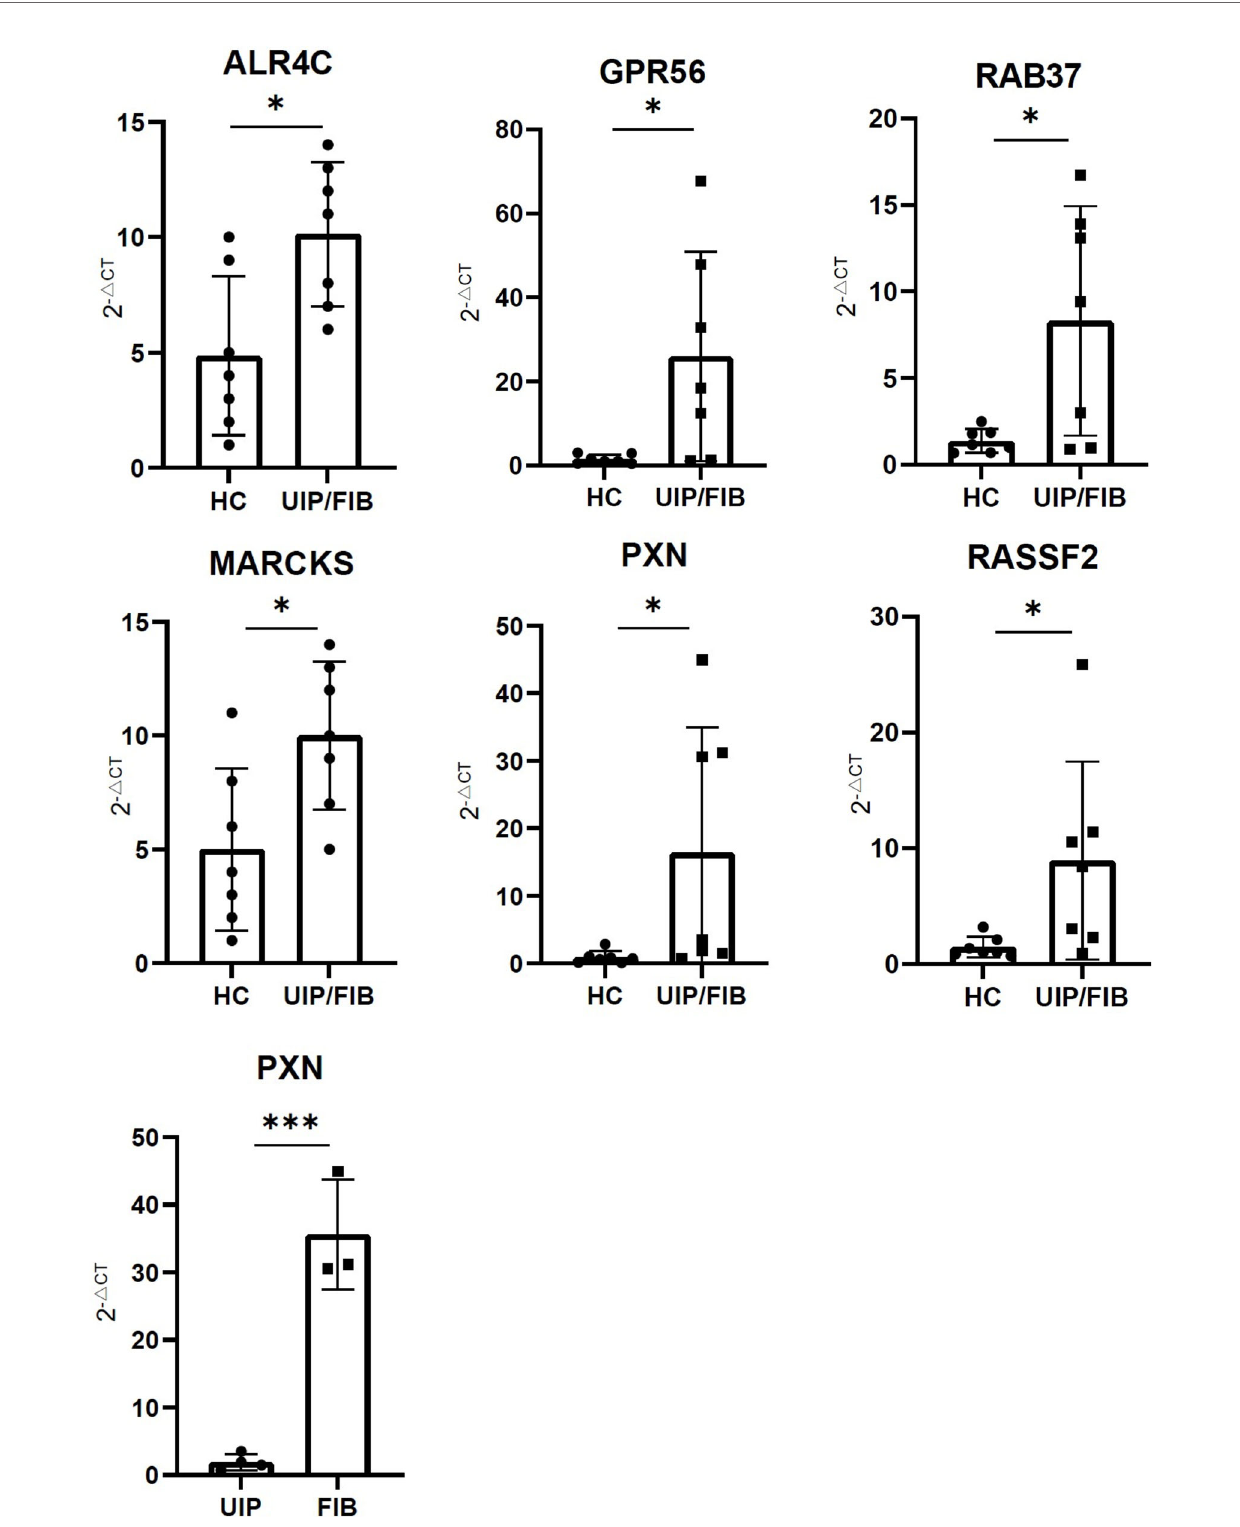
FIGURE 7 | The expression of ALR4C, RAB37, GPR56, MARCKS, PXN, and RASSF2 between healthy control and UIP/FIB patients. The expression of PXN between UIP and FIB patients. *** means P < 0.01, * means P <